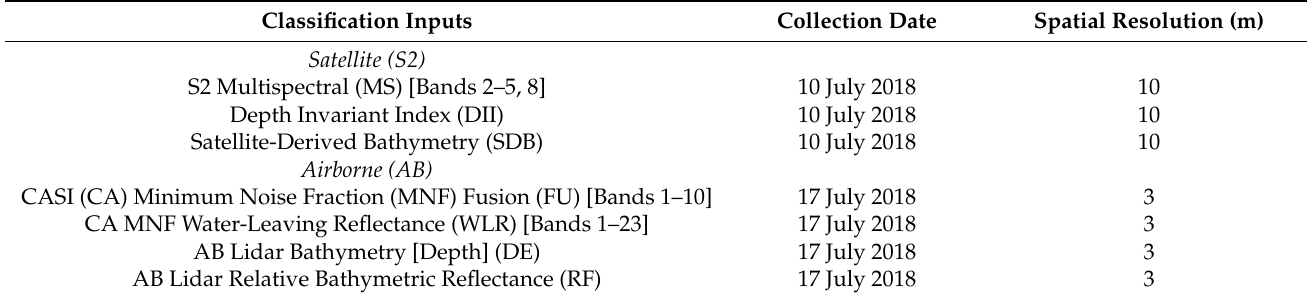
Table 4. Summary of satellite and airborne classification